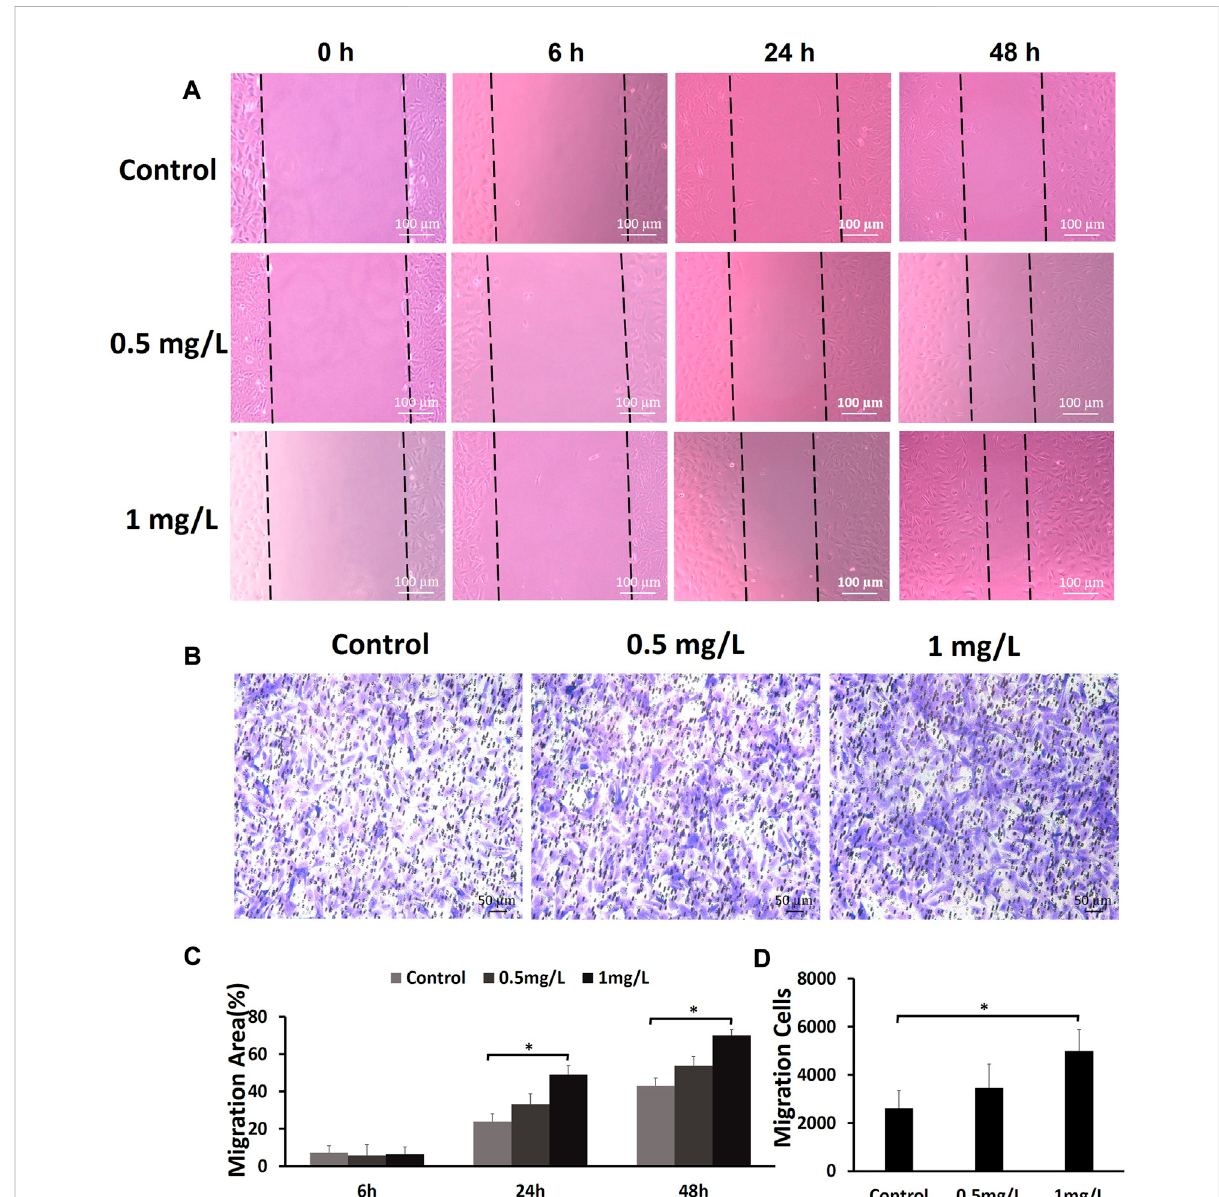
FIGURE 6 The effects of COS on the migration of fi broblasts (A) The wound healing scratch assays showed that 1 mg/ml COS markedly enhanced the motility of fi broblasts. (B) The transwell assays showed that compared with the control group, 1 mg/ml COS signi fi cantly promoted cell migration. (C,D) Quanti fi cation of the results from the wound healing assays and transwell assays is shown in the fi gure. * p < 0.05. The shorter scale bar represents 50 μ m, and the longer scale bar represents 100